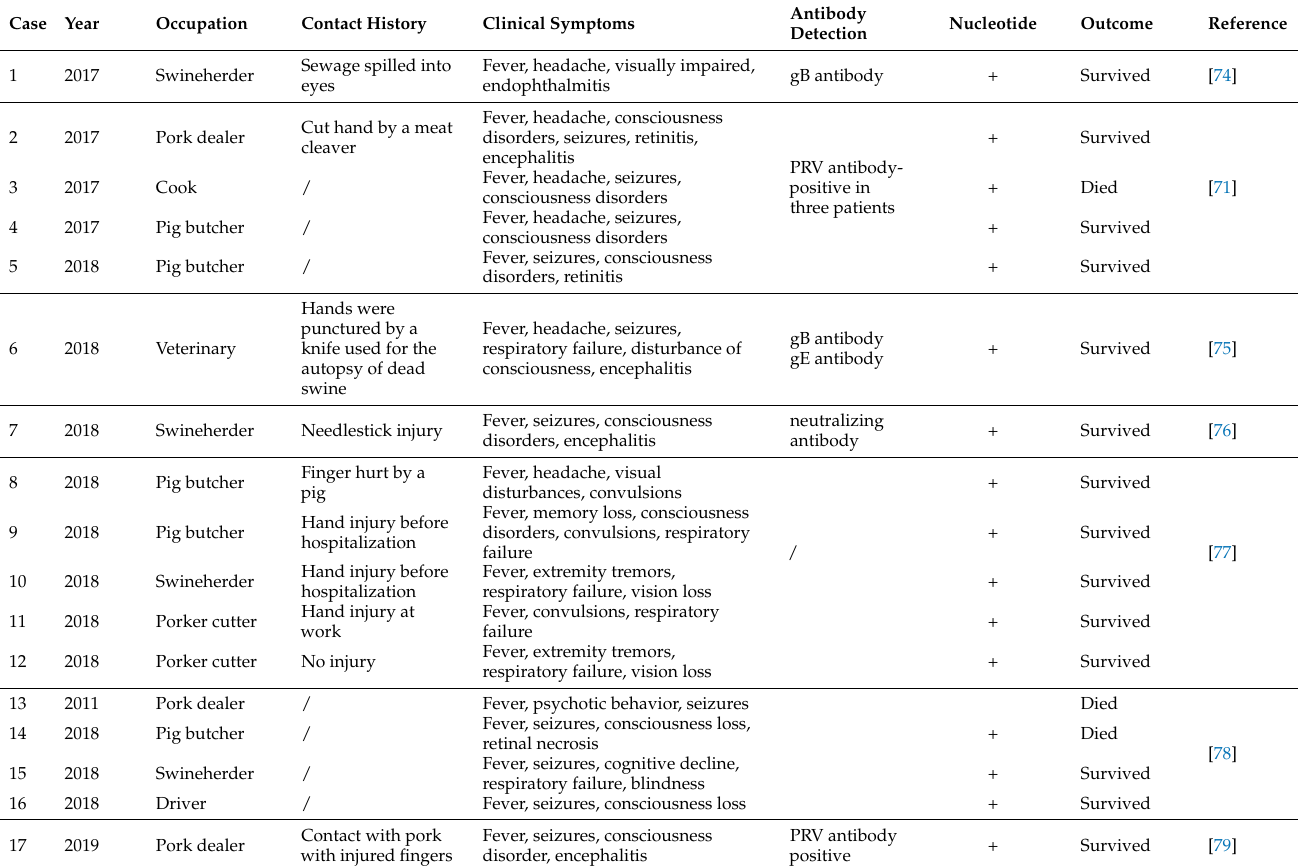
Table 4. Case reports of human infection with PRV between 2017 and